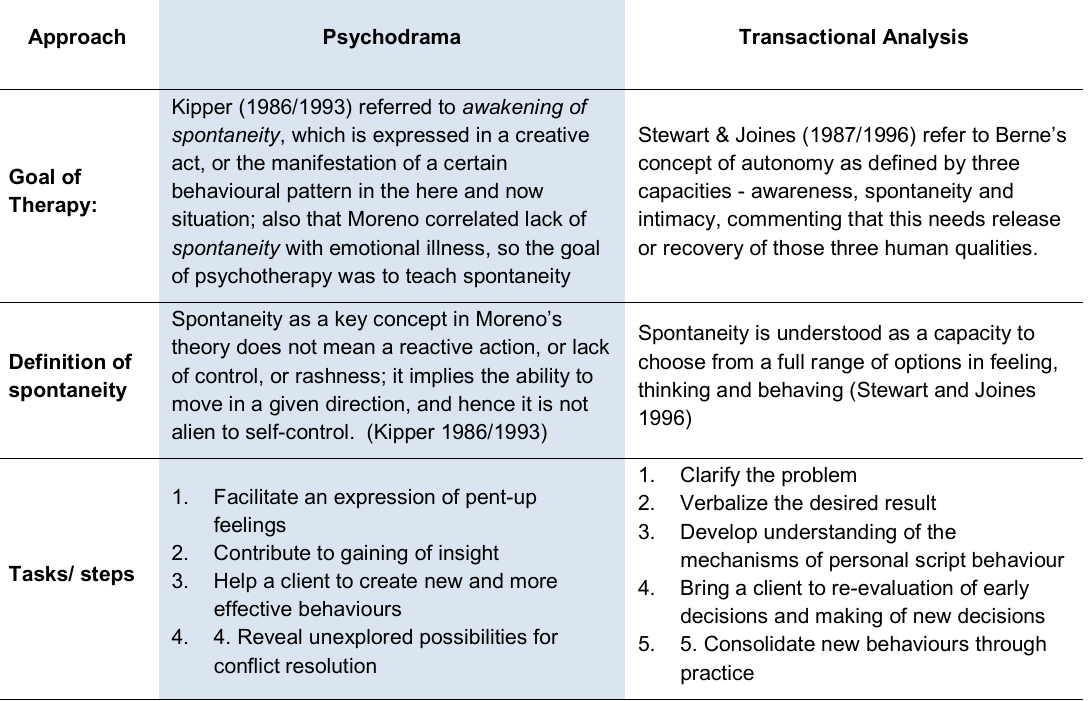
Table 1. Similar elements in the conceptual bases of psychodrama and TA